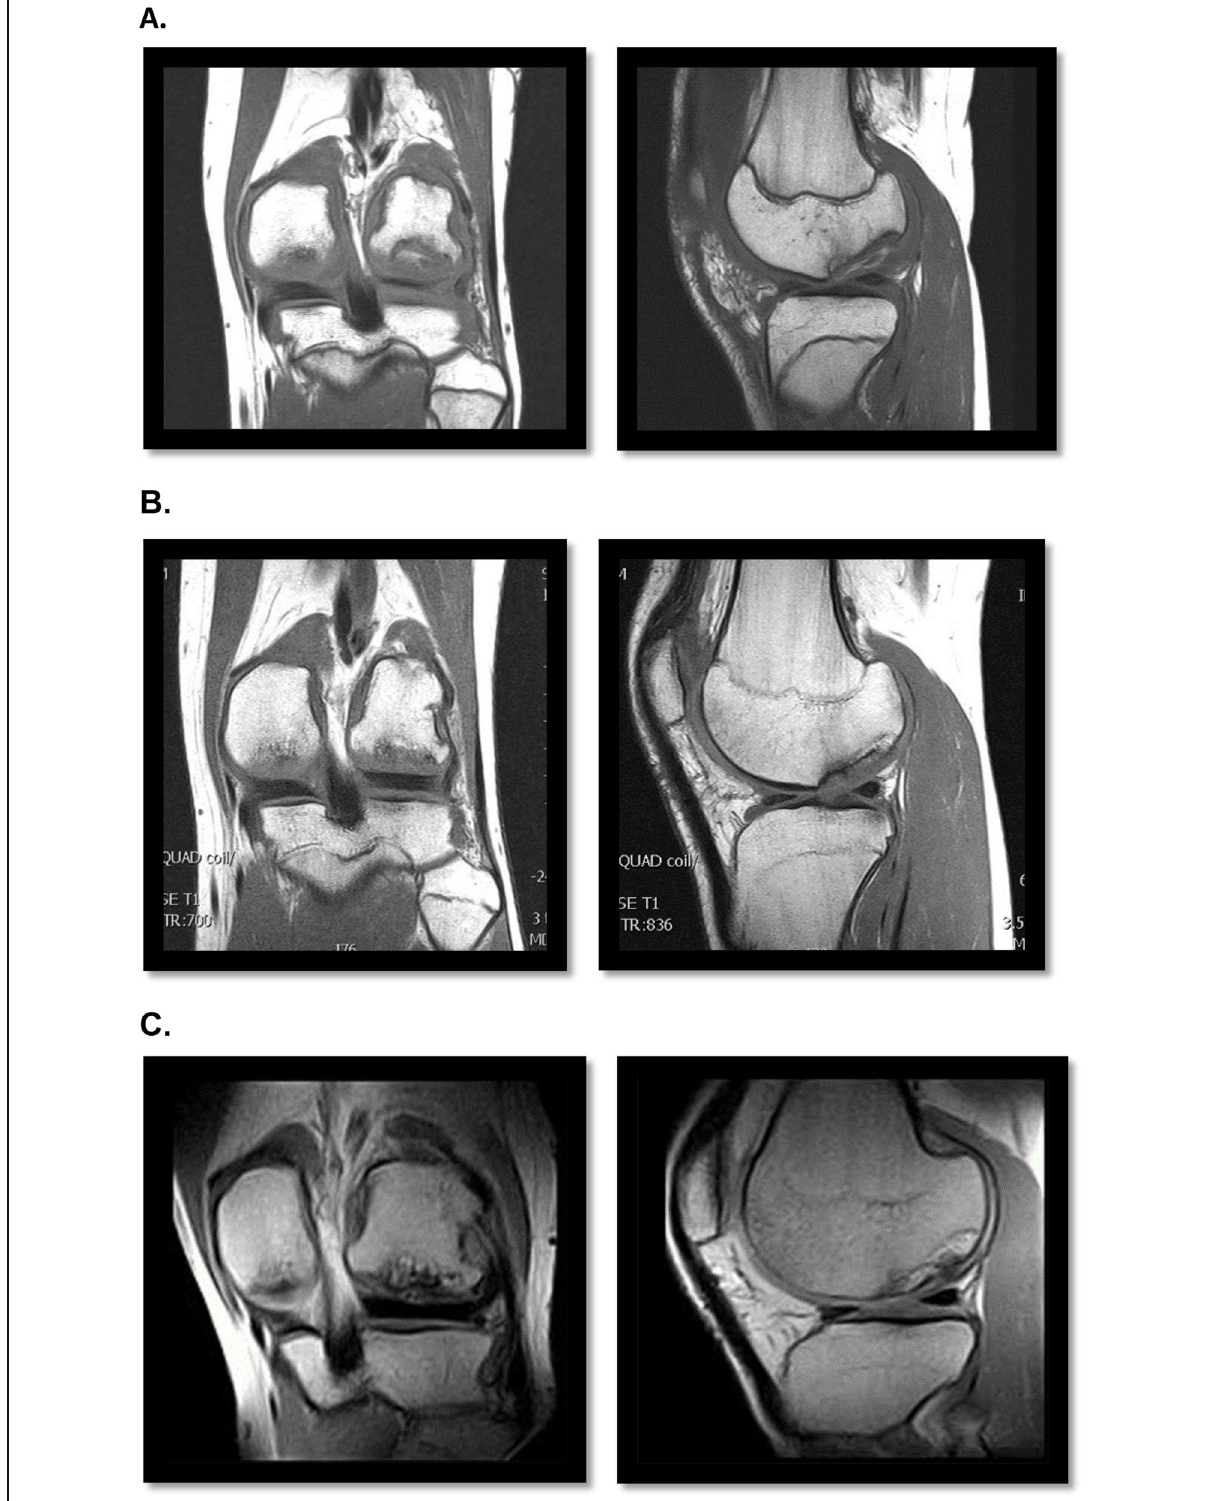
Fig. 4 Sample case. Magnetic resonance imaging (coronal and sagittal view) of an osteochondritis dissecans on the lateral femoral condyle of the left knee in a 15 years old male treated with Maioregen® osteochondral scaffold. a Pre-operative; b 12 months follow-up; c 5 years